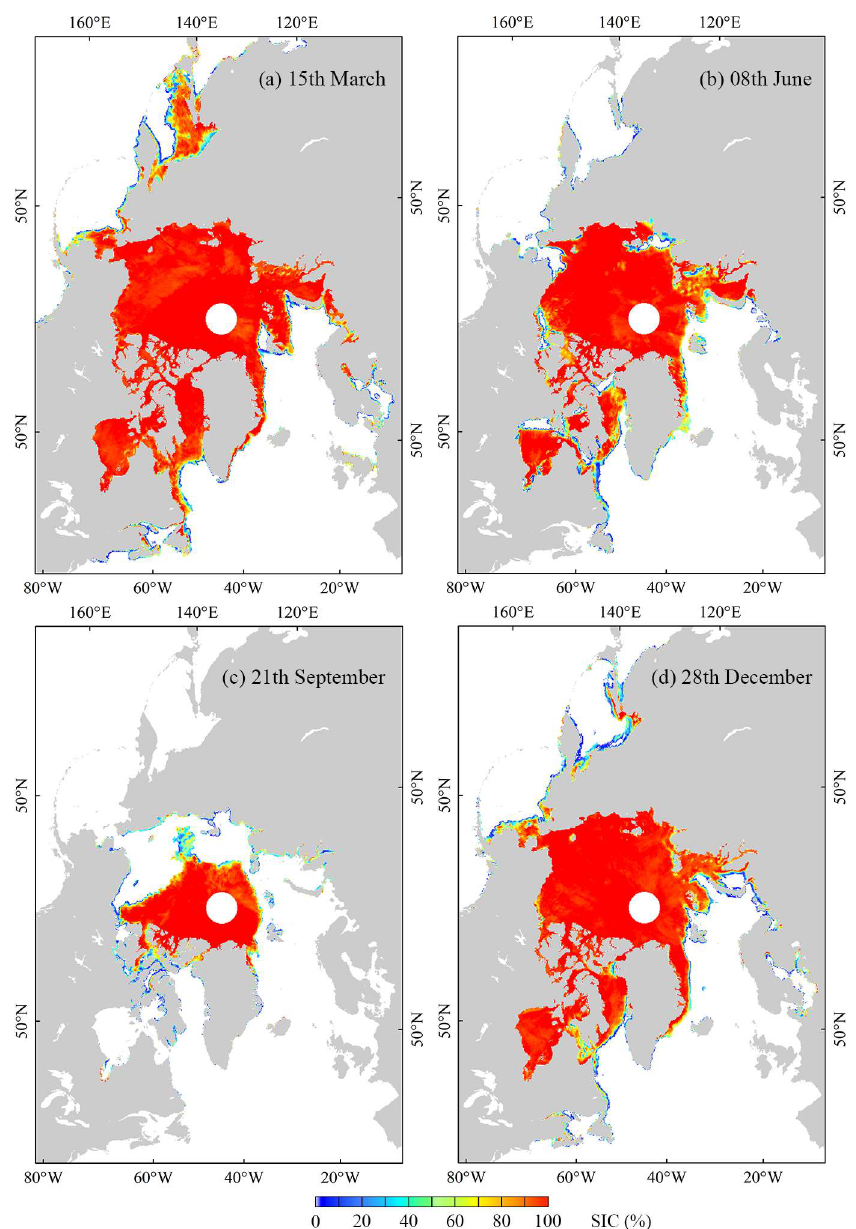
Figure 2. The SIC product derived from FY-3D MWRI TB data by an ASI dynamic tie points algorithm on 15 th March, 08 th June, 21 th September, and 28 th December